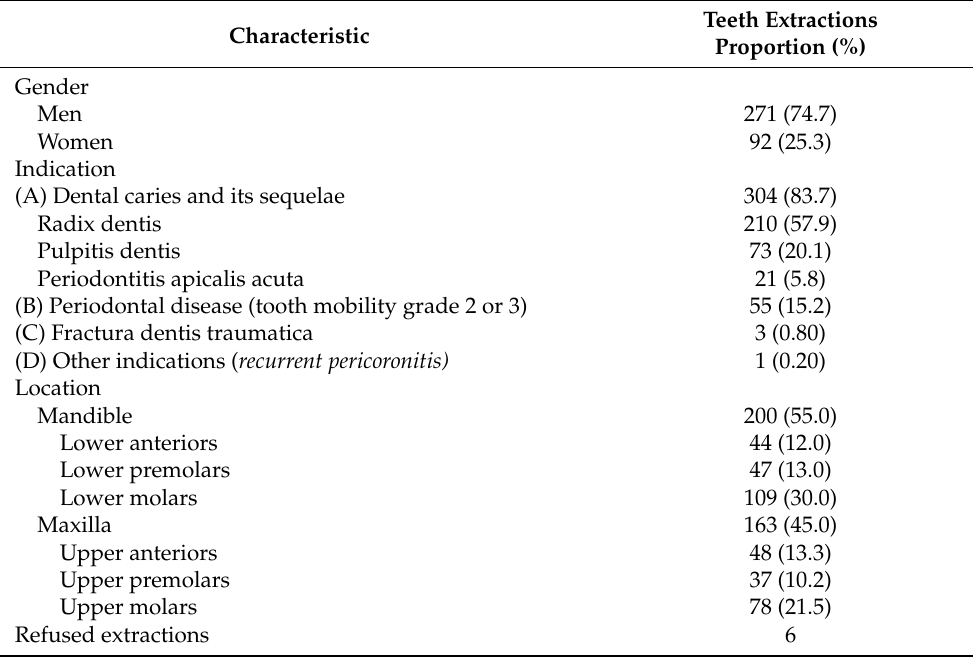
Table 2. Characteristics of the teeth extractions (n = 363) stratified by gender, indication and location; homeless people (n = 319), Bratislava, Slovakia,